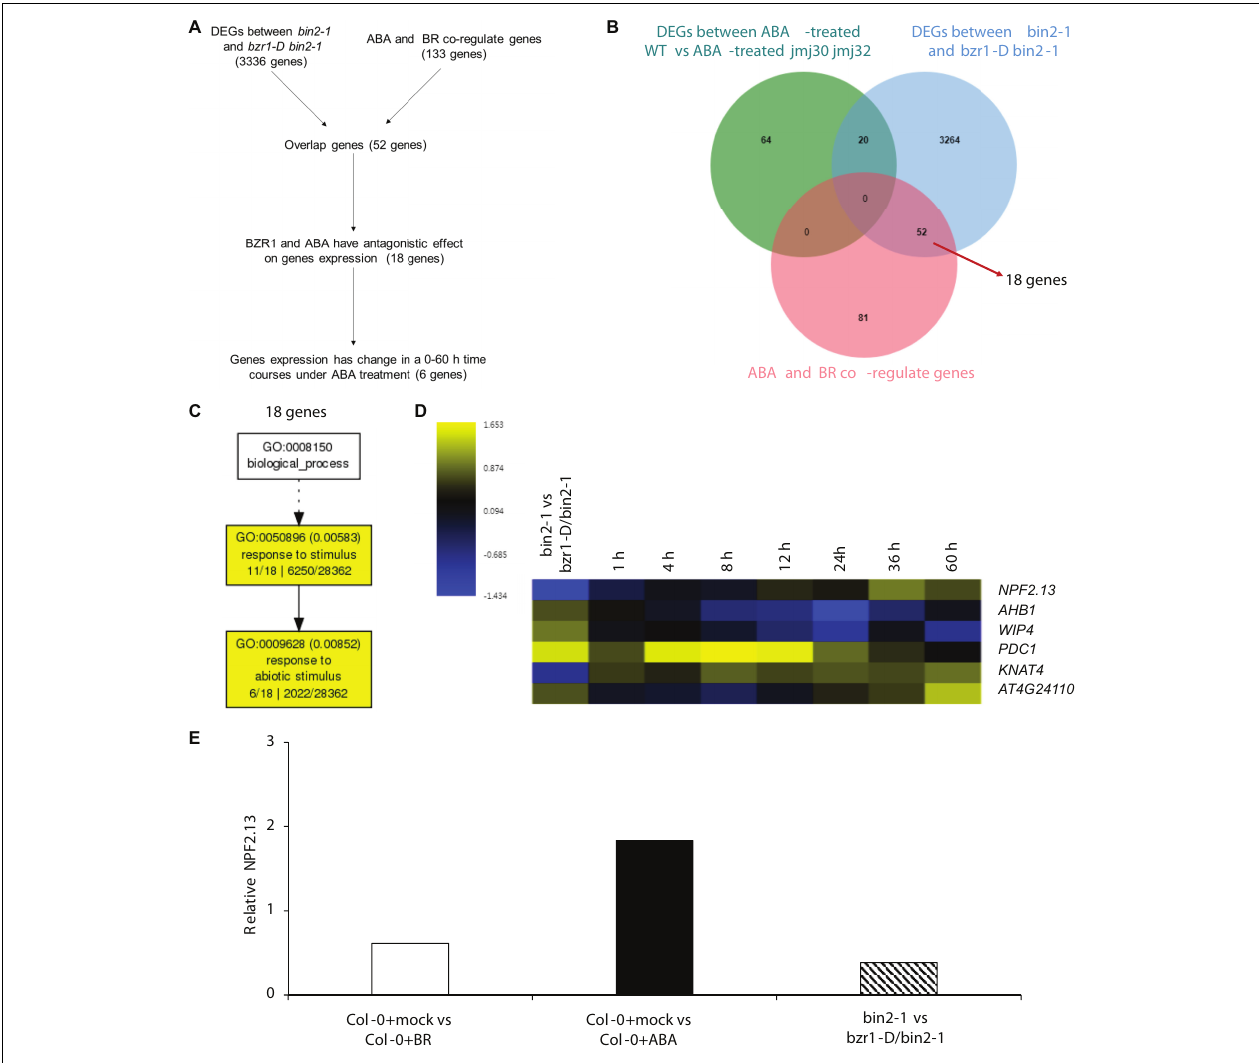
FIGURE 6 | BZR1 regulate ABA/BR responsive genes independently. (A) The flowchart of candidate genes selection. (B) Venn diagram showing the number of genes differentially expressed in ABA-treated wild-type (WT) and jmj30-2 jmj32-1 plants, the number of genes differentially expressed in bin2-1 and bzr1-D bin2-1 plants and the number of ABA/BR co-regulated genes. (C) The GO analysis among 18 BZR1 and ABA/BR co-regulated genes. (D) Heatmap displaying the log 2 FC (fold change) of the 18 candidates based on two transcriptome datasets. (E) Relative expression of NPF2.13 by RNA-seq. Y-axis represents FC. p < 0.05.